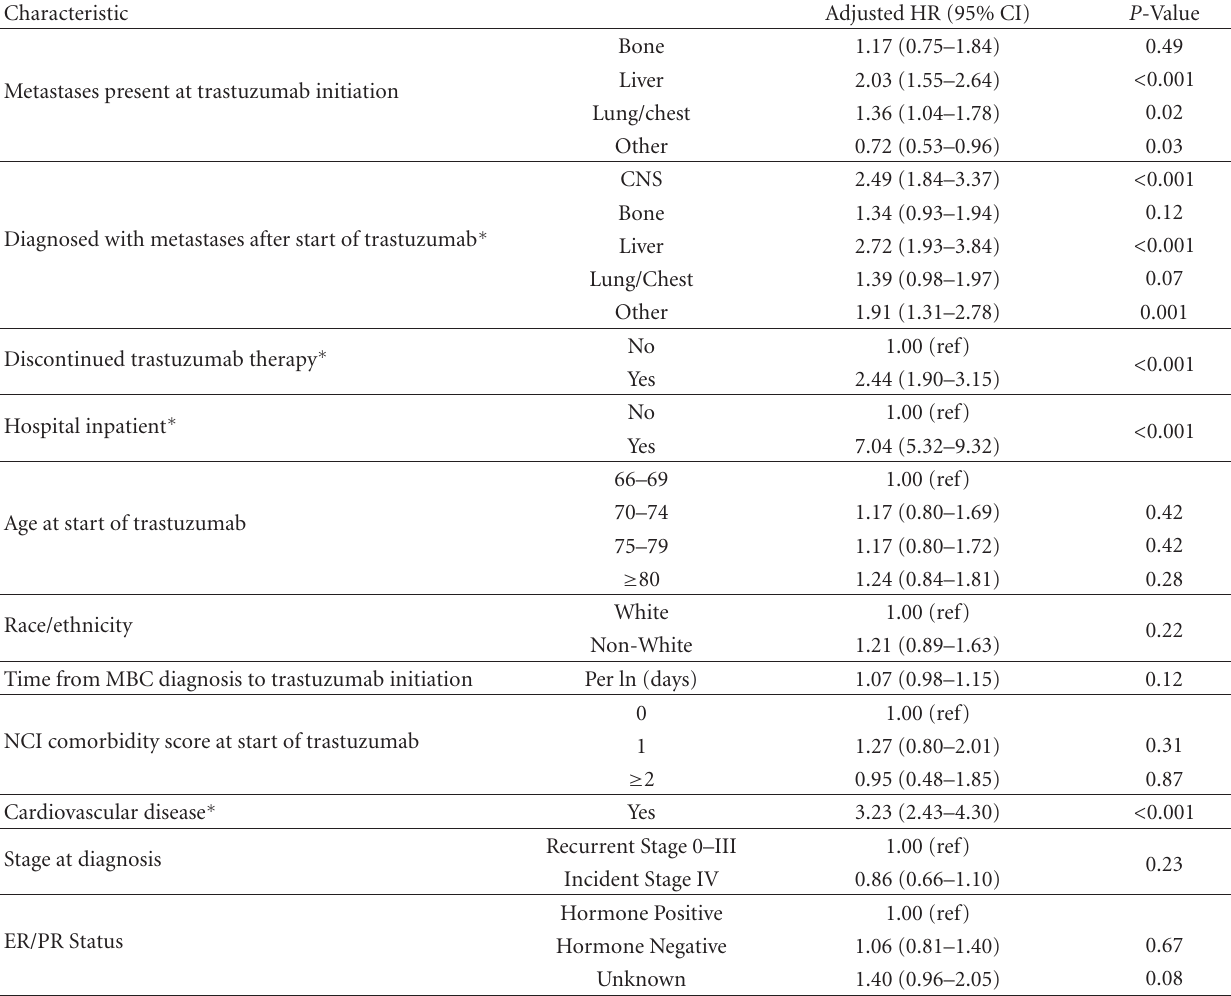
Table 4: Adjusted model for risk of